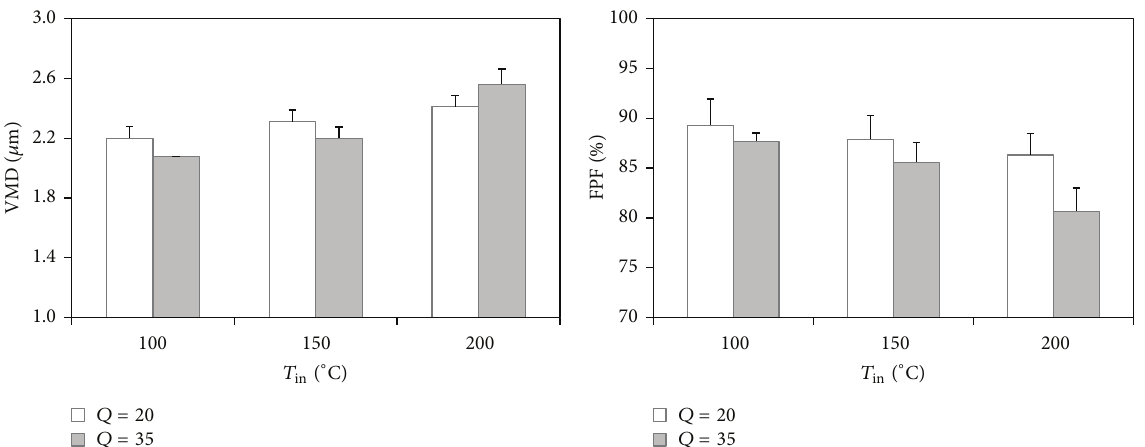
Figure 6: Volumetric median diameter (VMD) and fraction of fine particles (FPF) for PAD microparticles as a function of the temperature and the flow rate of the drying air (m 3 /hr). Error bars denote the standard deviation.